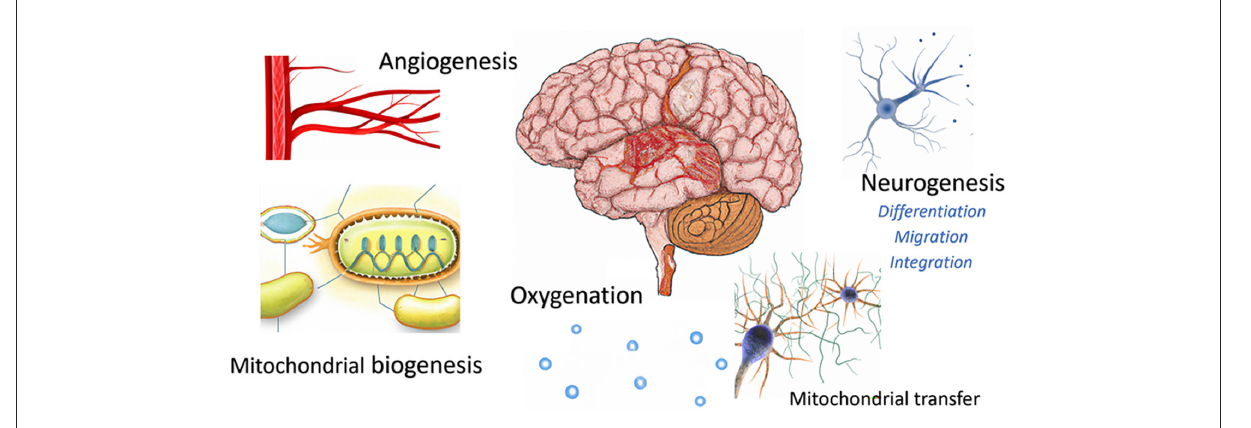
FIGURE1 Brain regeneration mechanisms induced by HHP